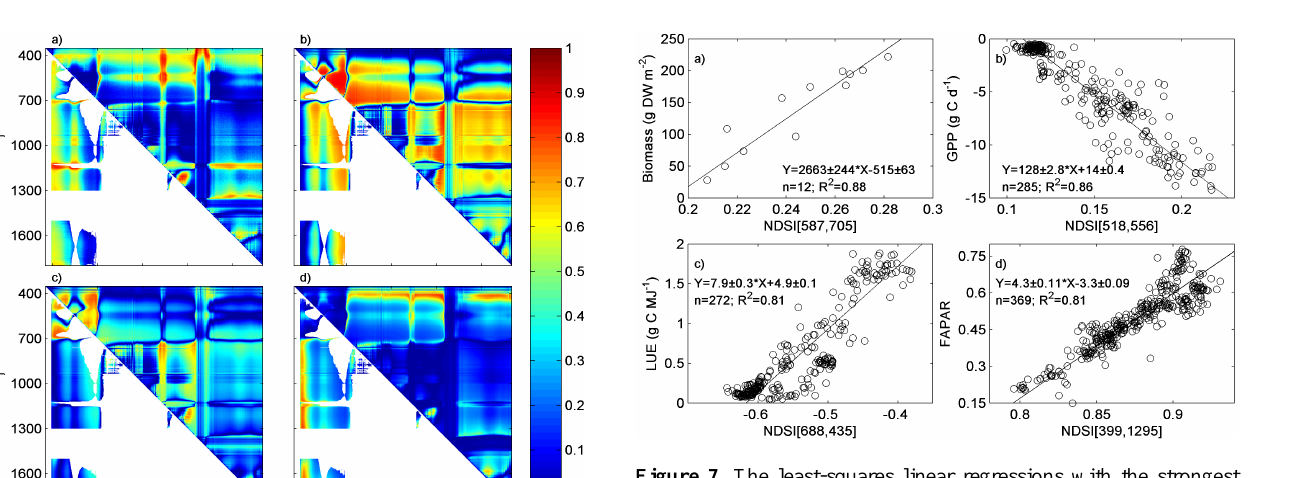
Figure 7. The least-squares linear regressions with the strongest relationships between the normalised difference spectral index (NDSI) and (a) dry weight biomass, (b) gross primary productivity (GPP), (c) light use efficiency (LUE), and (d) fraction of photosyn- thetically active radiation absorbed by the vegetation (FAPAR). In the equations, the slope and intercepts ( ± 1SD) is